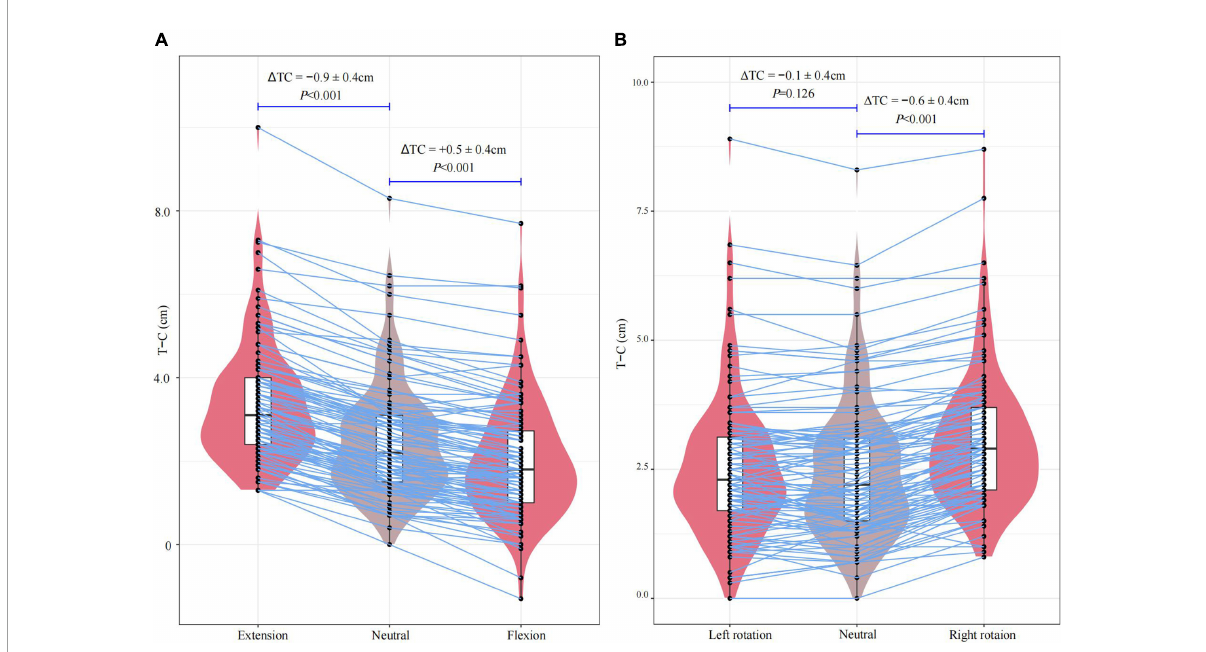
FIGURE4 The distance of the ETT tip movement after changing head position: (A) 45 ◦ extension and 45 ◦ flexion from the neutral position; (B) 60 ◦ right rotation and 60 ◦ left rotation from the neutral position.